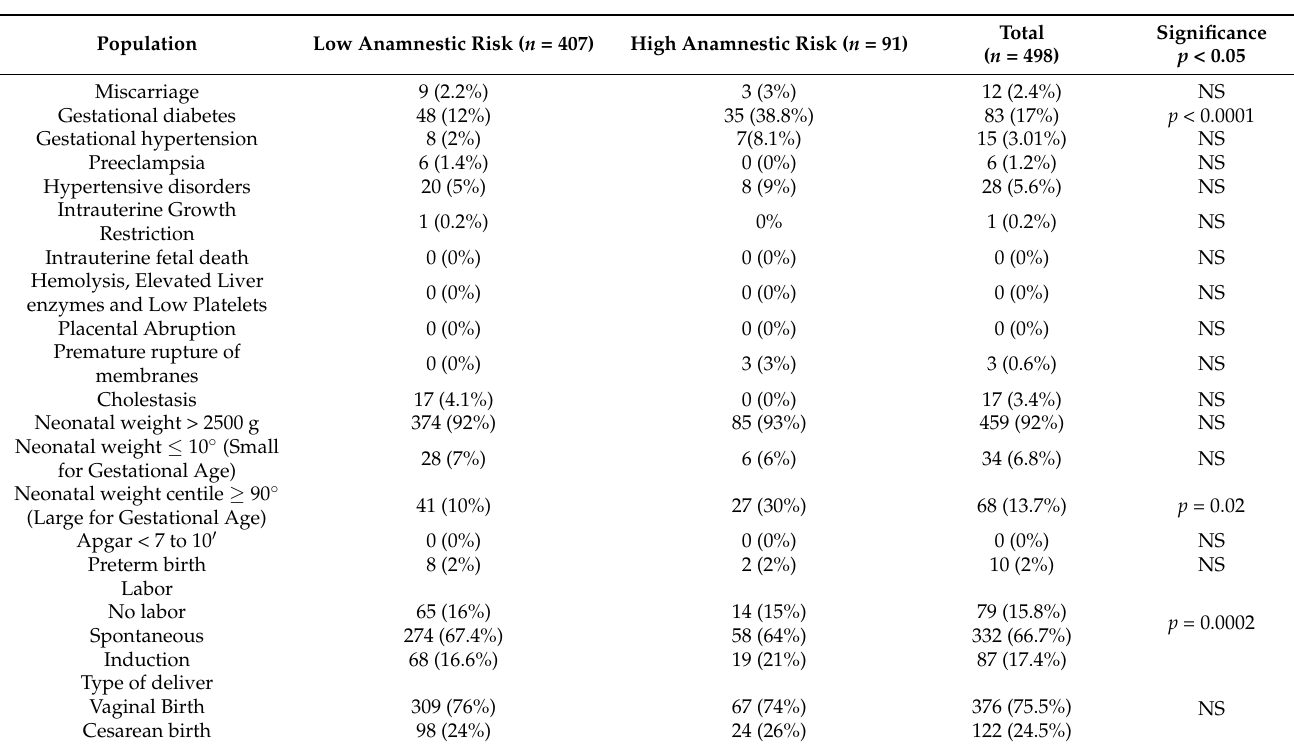
Table 4. Adverse outcomes in the study